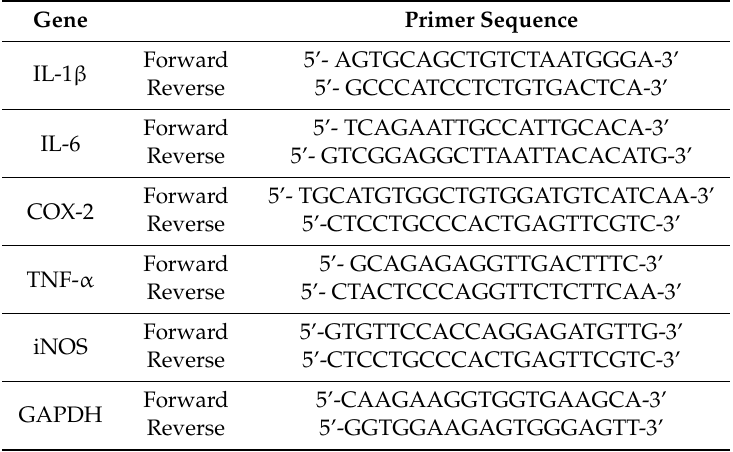
Table 2. Real-time PCR primer